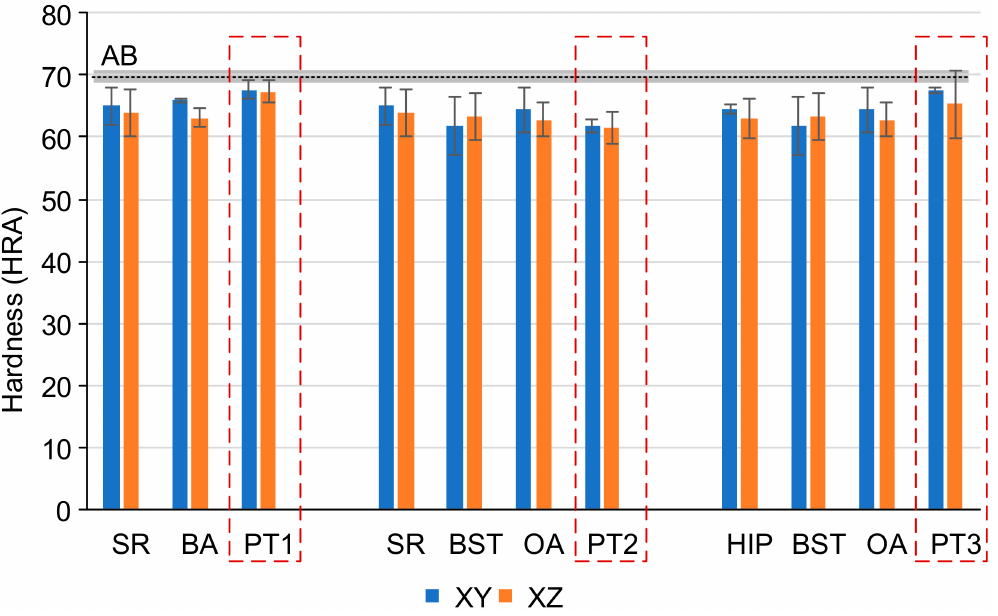
Figure 9. Hardness measurements before and after each post-treatment stage.